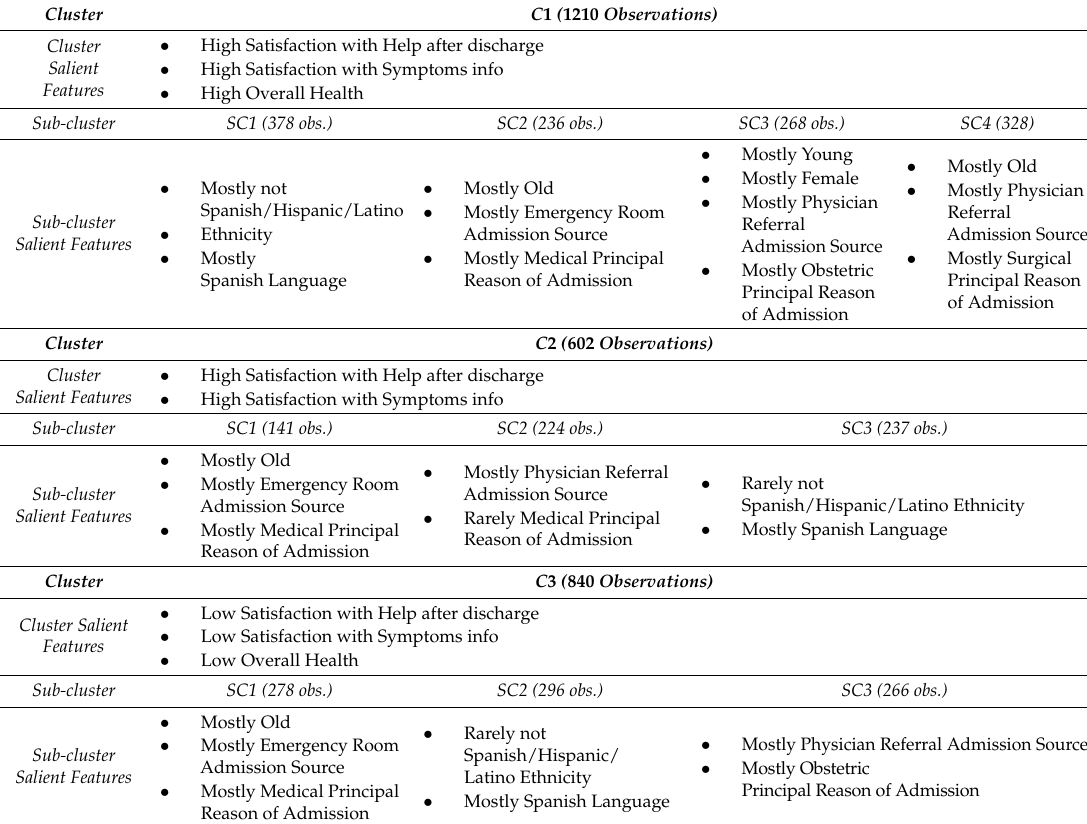
Table 9. Salient features of all satisfaction clusters and their demographic sub-clusters (Numbers in parenthesis demonstrate the clusters’ populations).